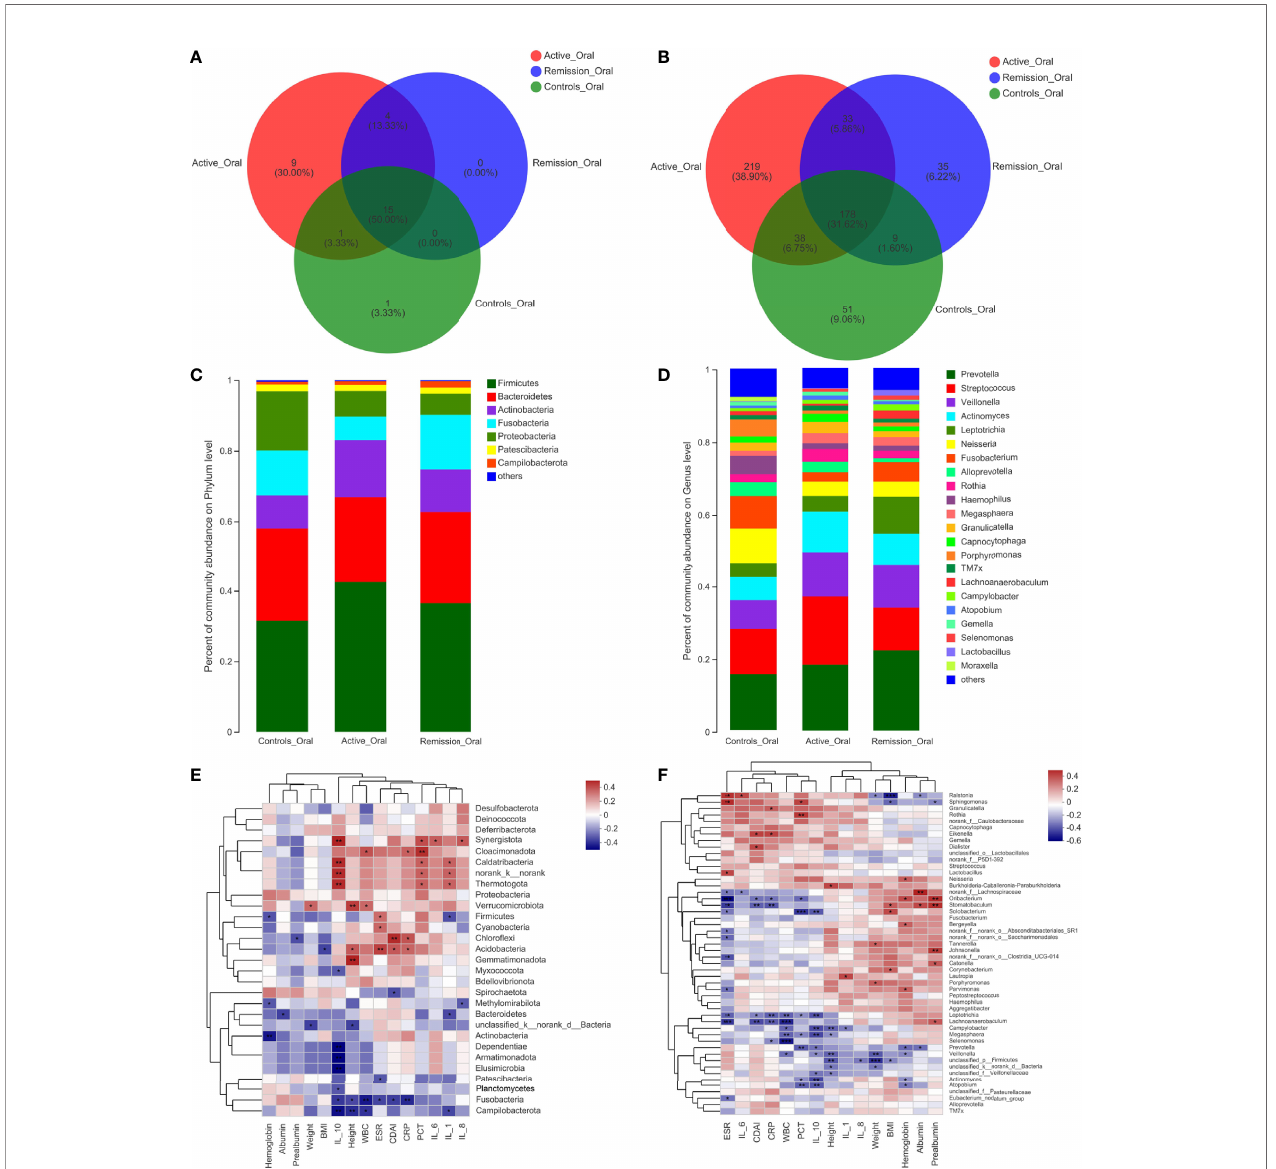
FIGURE 3 | Structure analysis of the oral microbiota in patients with CD. (A, B) Venn diagram indicating the overlap of OTUs in the categories on the phylum and genus levels, respectively. (C, D) Barplot of the relative abundances of different taxa on the phylum and genus levels, respectively. (E, F) Heatmap revealing the association between oral microbiota and clinical factors on the phylum and genus levels, respectively. *, **, and *** correspond to p-values <0.05, 0.01, and 0.001,